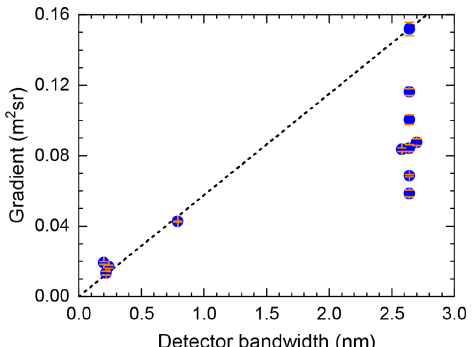
Figure 11. Impact of BBA fluorescence on the humidity measure- ment (expressed by gradient m ) as a function of detector band- width. Results are shown for RAMSES measurements with the dis- crete detection channels (0.22nm bandwidth), the water spectrome- ter (0.79nm), and the UVA spectrometer (2.64nm). Closely spaced data points were shifted slightly to separate them graphically. Error bars indicate retrieval uncertainties of m . The fit for the straight line through the origin was obtained by neglecting all values at 2.64nm except for the maximum.